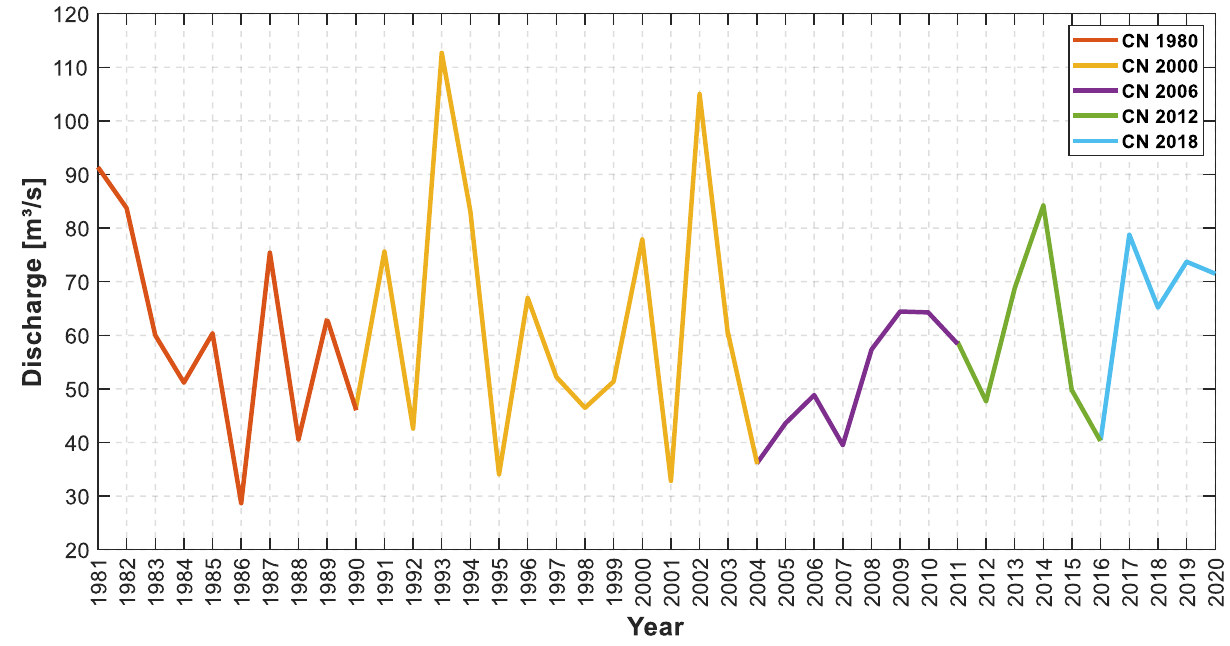
Figure 13. Annual maximum discharge at time-variant CN conditions: simulations by the FEST-WB model enforced with the ERA5-Land data at the Bovisio-Masciago gauge section.